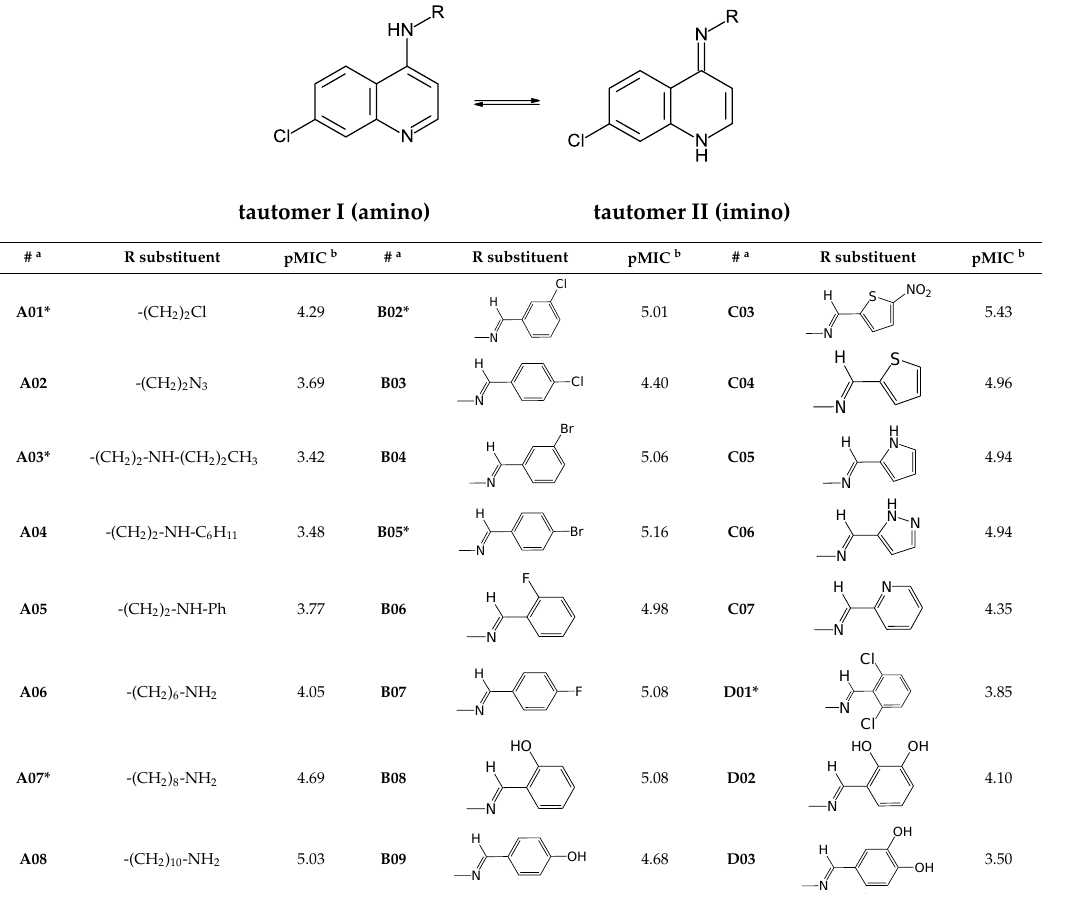
Table 2. Chemical structures (tautomers I and II, R substituent) and biological activity values (pMIC) of the 7-chloro-4-aminoquinoline derivatives for series A ‒ D .